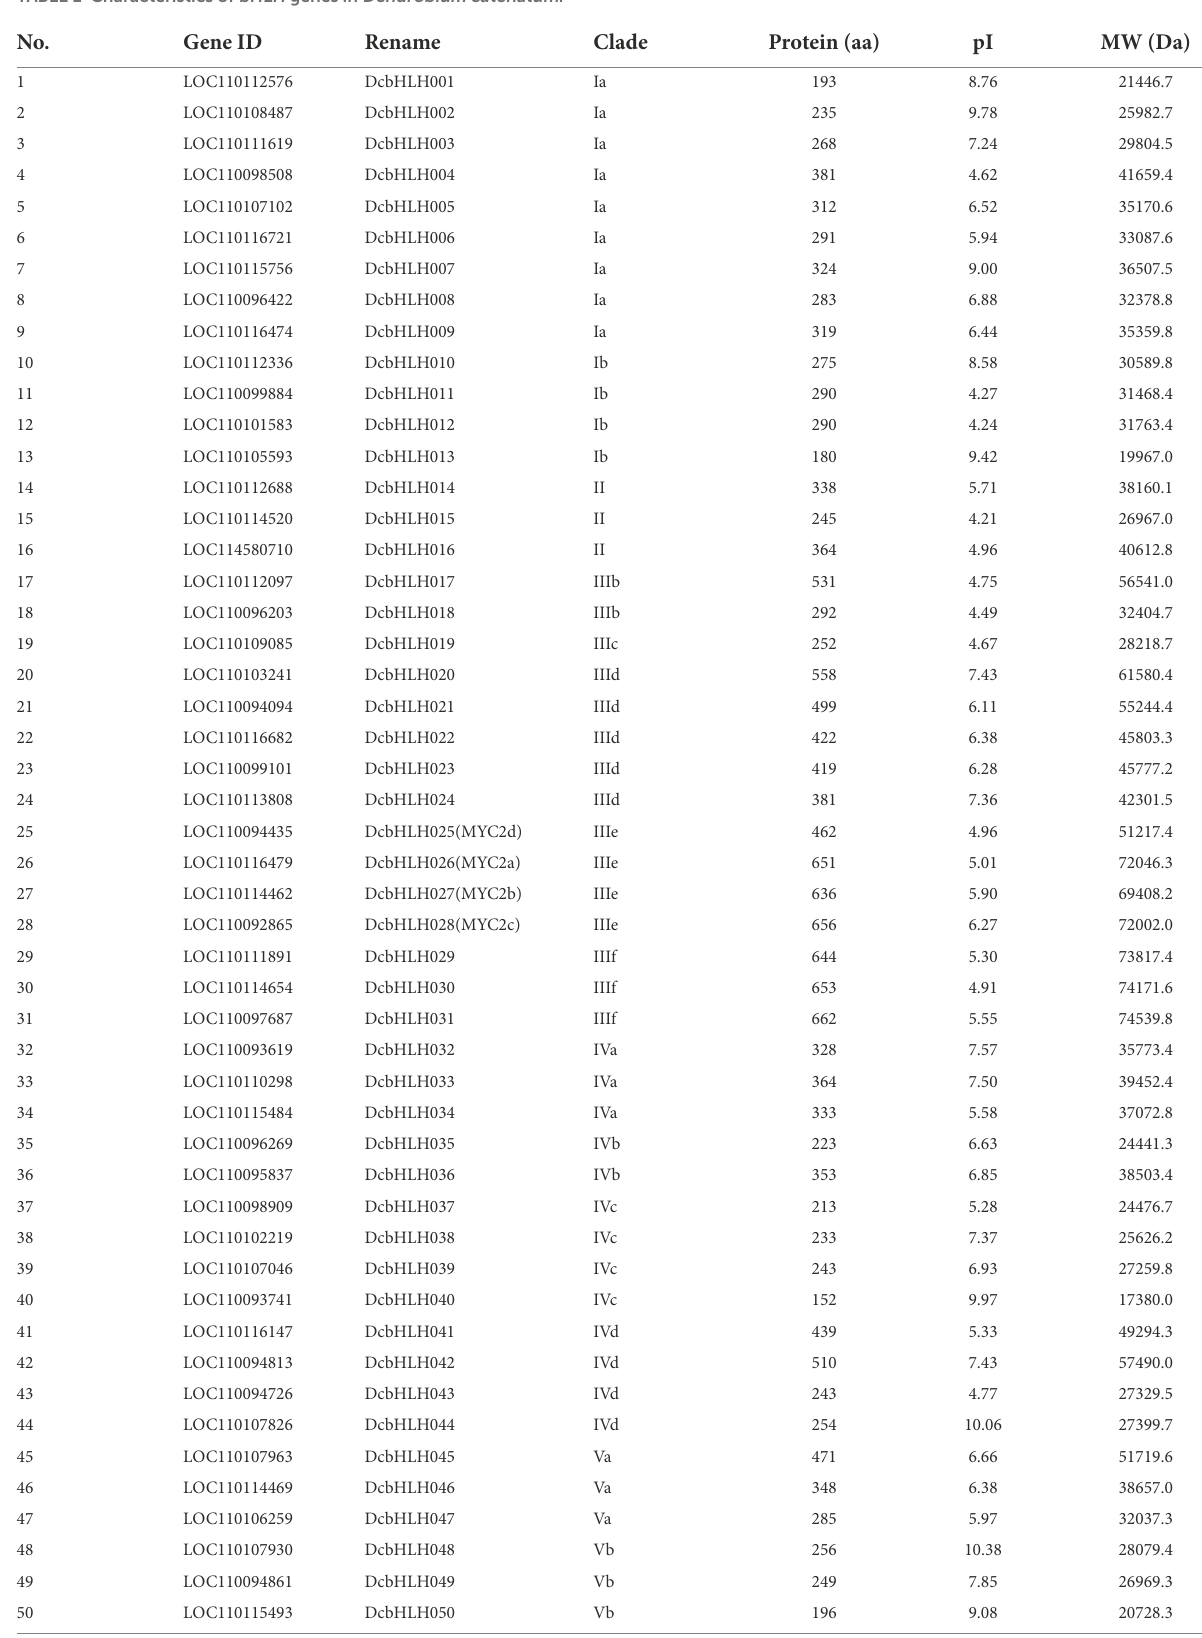
TABLE 1 Characteristics of bHLH genes in Dendrobium